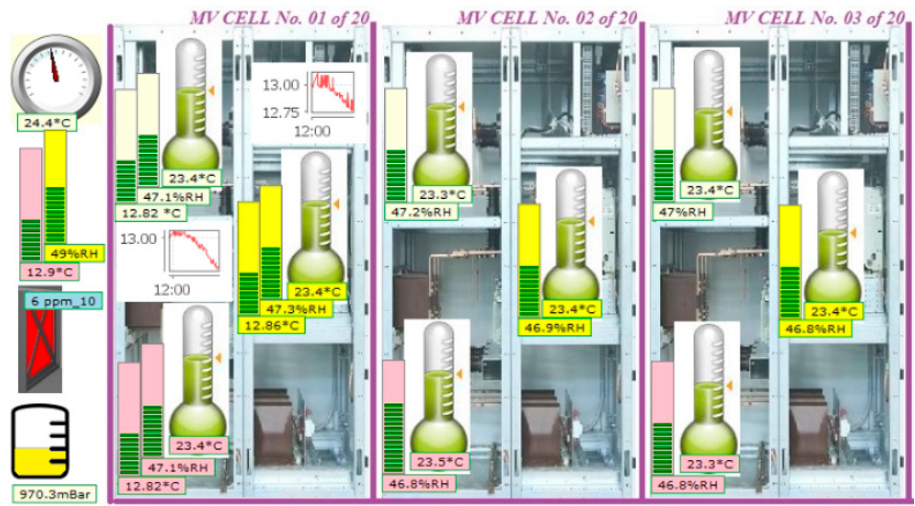
Figure 10. Example of locally microclimate monitoring using SCADA web page with sensors for 3 cells.